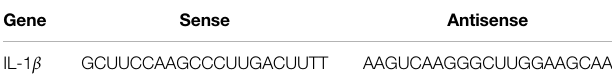
TABLE 1 | The sequence of